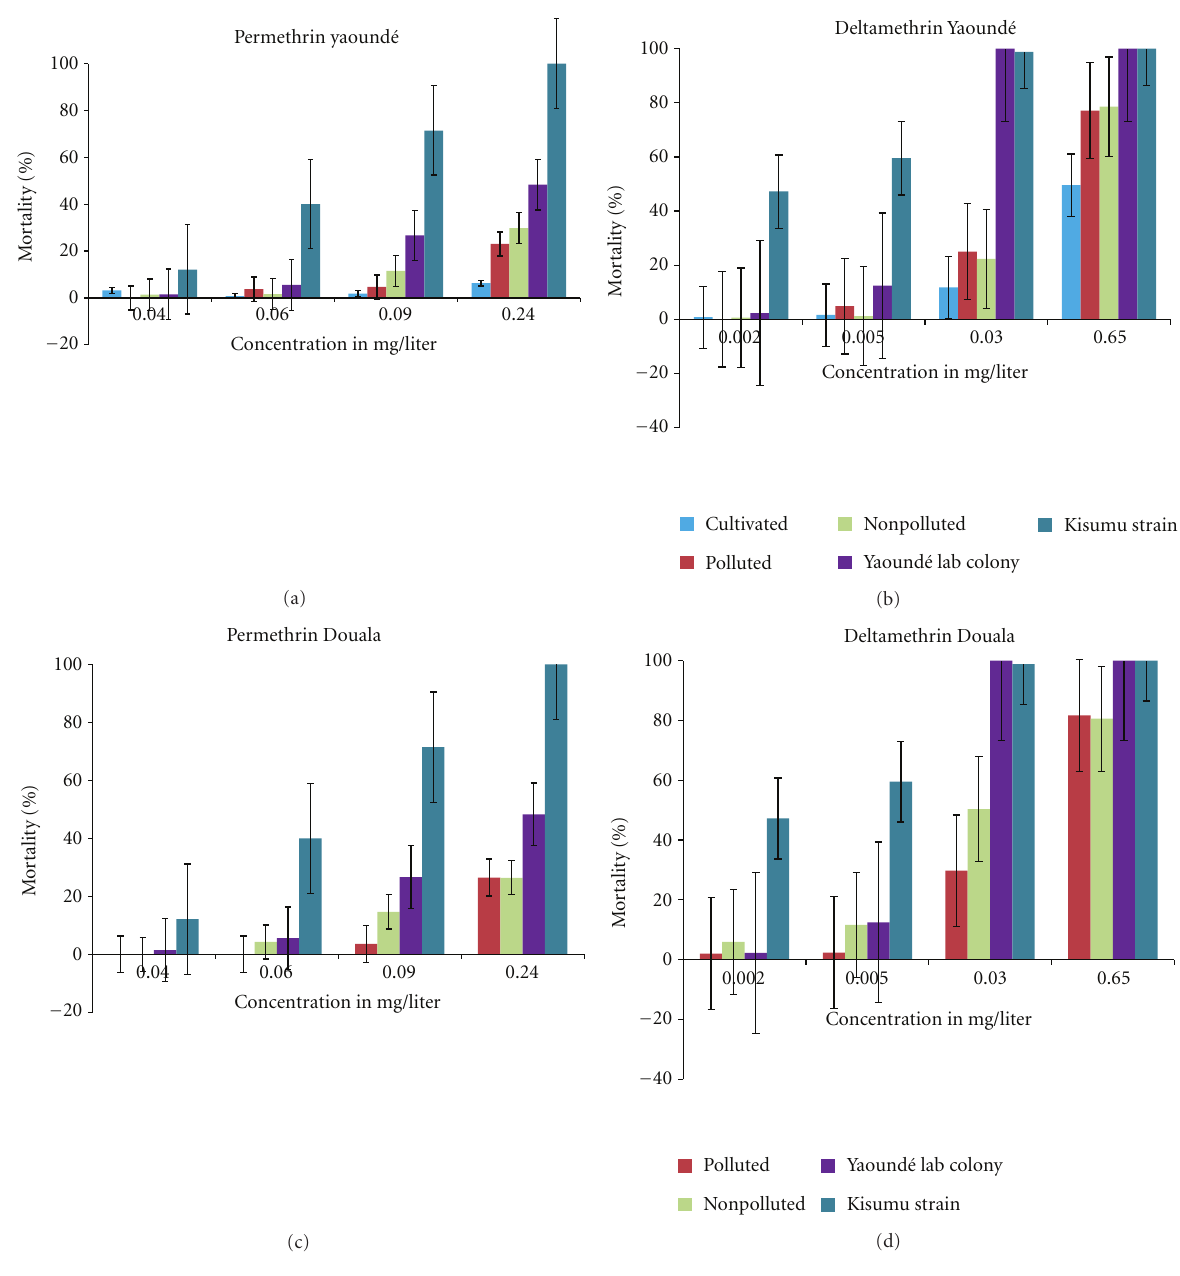
Figure 1: Diagrams showing mortality rates of third and fourth instars larvae after exposure to sublethal concentrations of permethrin and deltamethrin in Yaound´e ((a) and (b)) and Douala ((c) and (d)).